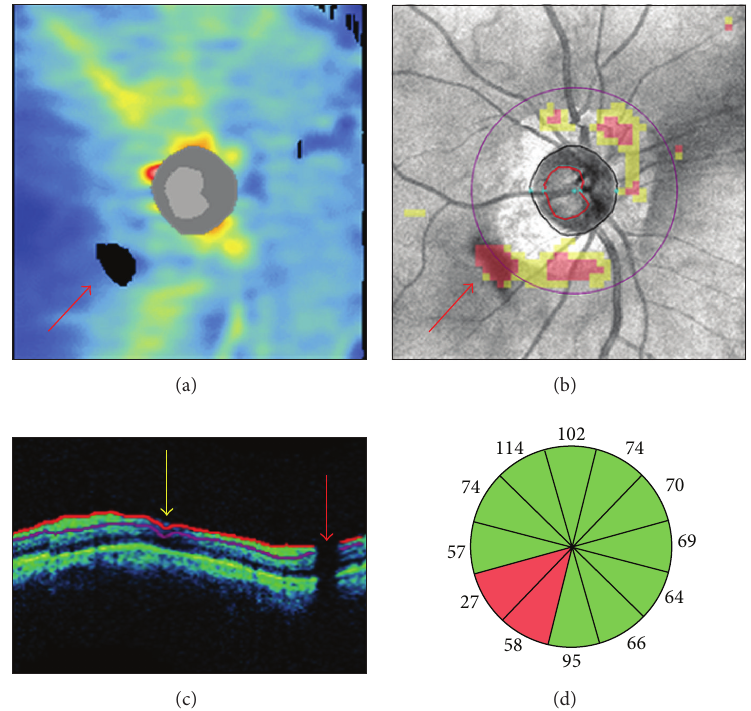
Figure 2: Floater overlying the scan circle. In a Cirrus HD-OCT right optic disc scan, a floater determined a black area of missing data on the retinal nerve fiber layer (RNFL) thickness map ((a) red arrow) and a cluster of red “superpixels” on the RNFL deviation map overlying the inferotemporal sectors of the scan circle (b). A characteristic vertical black shadow interrupted the retinal profile and the RNFL segmentation lines on the circular tomogram ((c) red arrow). A superonasal RNFL segmentation artifact from other cause is indicated by the yellow arrow. In (d), the inferotemporal clock hours underlying the floater presented RNFL thinning with “outside normal limits” classification